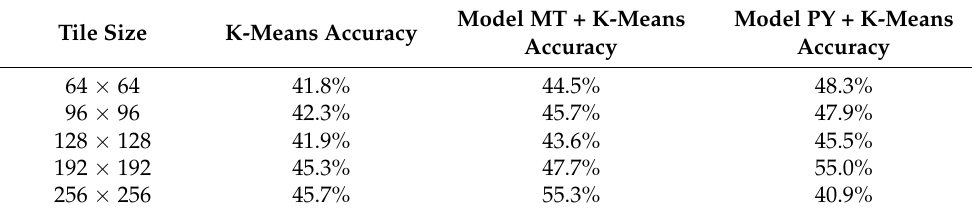
Table 9. Tile accuracies of the unsupervised learning methods for Pick